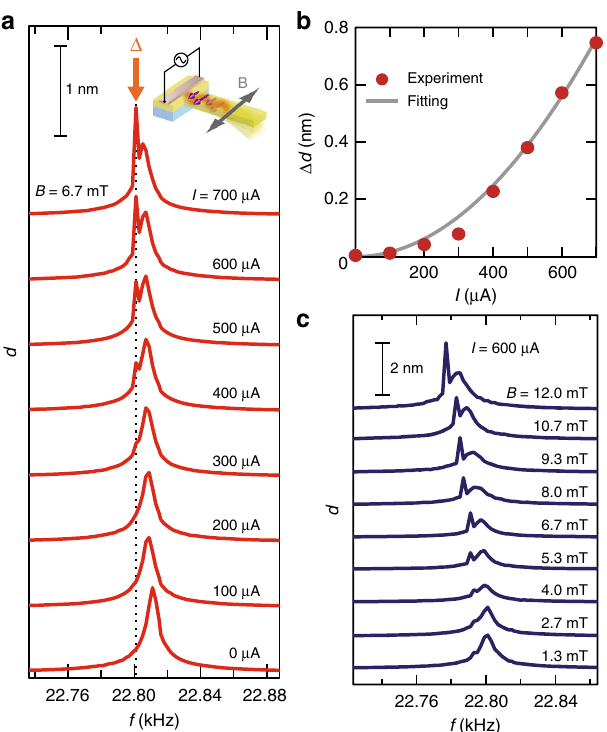
Fig. 4 Current and fi eld dependence of cantilever fl uctuation d . a Amplitude of the cantilever fl uctuation d at various values of the heating current I . The excitation frequency, 22.800kHz, is shown by the dotted line in the fi gure. b Fluctuation amplitude of the cantilever at the excitation frequency as a function of the current amplitude I . The red disks represent the experimental data. The gray solid curve, which is proportional to I 2 , is a curve fi tted to the data. c Amplitude of the cantilever fl uctuation d at various values of the a.c. fi eld strength. The current amplitude is 600 μ